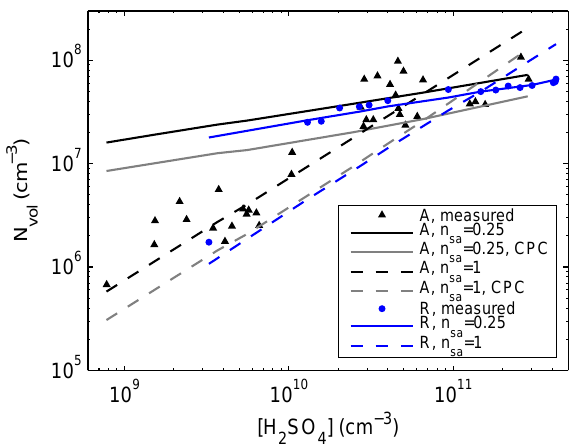
Figure 16. The measured and simulated volatile nucleation mode concentrations as a function of raw exhaust sulfuric acid vapor con- centration. Particle concentrations are normalized to raw exhaust by dilution ratio 12. Measurement data for R cases are obtained from Rönkkö et al. (2013) and for A cases from Arnold et al.